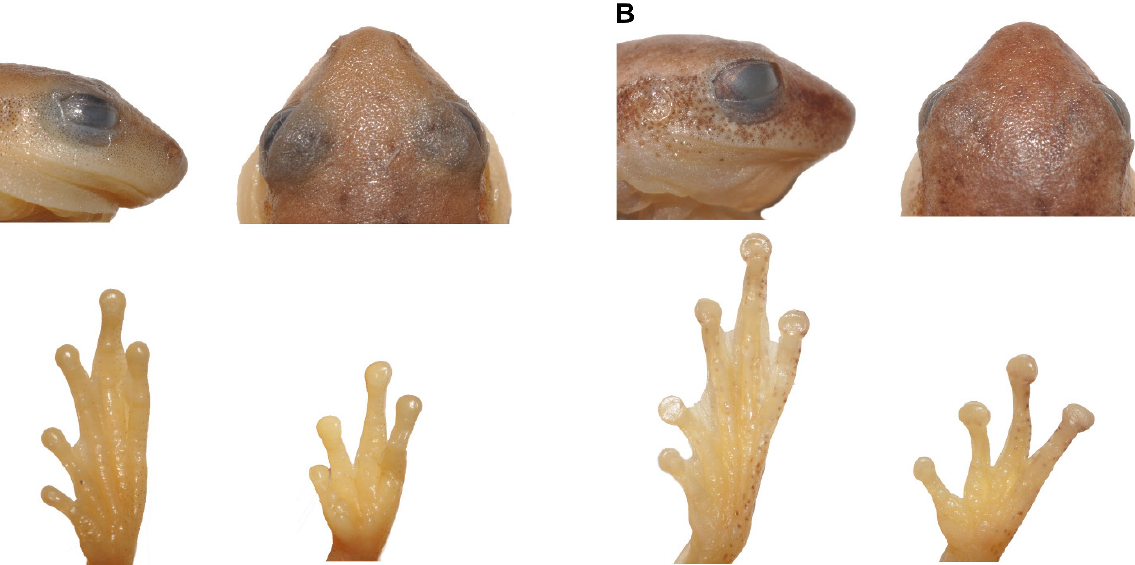
Figure 5. Preserved specimens assigned to Lineages B and E. Note the variation in color pattern and distribution of spots on the dorsum. ( A ) ( A – E ): Specimens UNEC 12433–37 collected from the type locality of D. nanus (Colonia Resistencia, Chaco, Argentina). ( F – I ): Specimens AAG-UFU 921–24 collected from Brejinho de Nazaré, Brazil. ( B ) ( A , B ): Specimens AAG-UFU 3252 and AAG-UFU 3254 from Belém, Pará, Brazil. ( C – I ): Specimens AAG-UFU 5306, AAG-UFU 5307, AAG- UFU 5309–11 and AAG-UFU 5342 from the type locality of D. walfordi (Forte Príncipe da Beira, Costa Marques, Rondônia, Brazil). On the other hand, morphometric data allowed us to detect morphological variation among lineages, especially between Lineages D and E, and between them and Lineages A, B, and C. Male SVL varied significantly among lineages (F 4.73 = 6.17; p < 0.001), as Line- age A differed from Lineages B ( p = 0.002) and C ( p = 0.004), and Lineage C differed from Lineage E ( p = 0.027) (Figure S7). Based on morphometric ratios (Table S3), PCA explained 58% of the data variation (Figure 6), with the first axis explaining 35% and the second axis